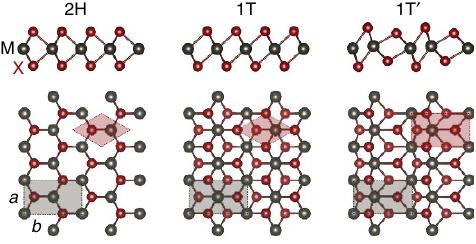
Figure 1 | Three crystal structures of monolayer TMDs. The top schematics show cross-sectional views and the bottom schematics show basal plane views. The grey atoms are transition metal atoms and the red atoms are chalcogen atoms; in all three phases, a layer of transition metal atoms (M) is sandwiched between two chalcogenide layers (X). The semiconducting 2H phase has trigonal prismatic structure, and the metallic 1T and semimetallic 1T 0 phases have octahedral and distorted octahedral structures, respectively. The grey shadow represents a rectangular computational cell with dimensions a (cid:3) b , and the red shadow represents the primitive